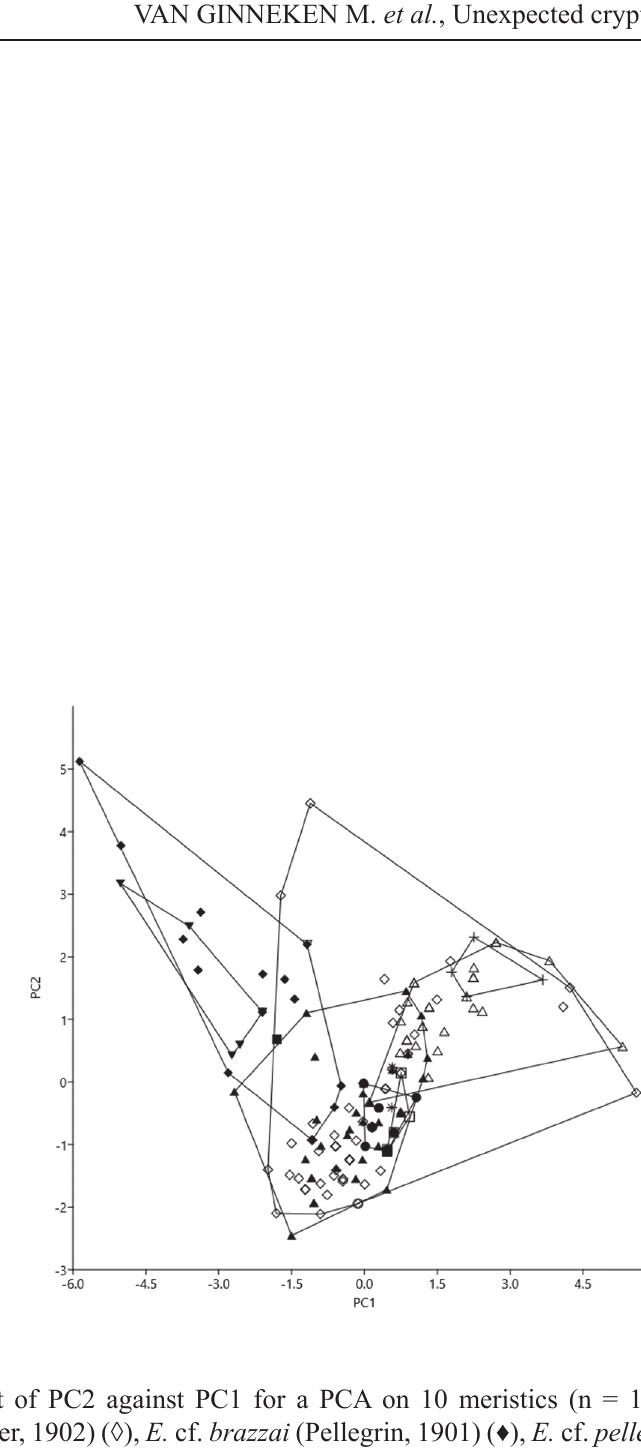
Fig. 4. Scatterplot of PC2 against PC1 for a PCA on 10 meristics (n = 177) of Enteromius : E. cf. miolepis (Boulenger, 1902) (◊), E. cf. brazzai (Pellegrin, 1901) ( ♦ ), E. cf. pellegrini (Poll, 1939) ( ∆ ), and E. cf. atromaculatus (Nichols & Griscom, 1917) ( ▲ ). Also shown are the type specimens examined of: E. miolepis (Boulenger, 1902) ( ○ ), E. holotaenia (Boulenger, 1904) (●), E. eutaenia (Boulenger, 1904) (□), E. kerstenii (Peters, 1868) ( ■ ), E. brazzai (Pellegrin, 1901) ( ), E. tshopoensis (De Vos, 1991) (▼), E. pellegrini (Poll, 1939) (+), and E. atromaculatus (Nichols & Griscom, 1917) (